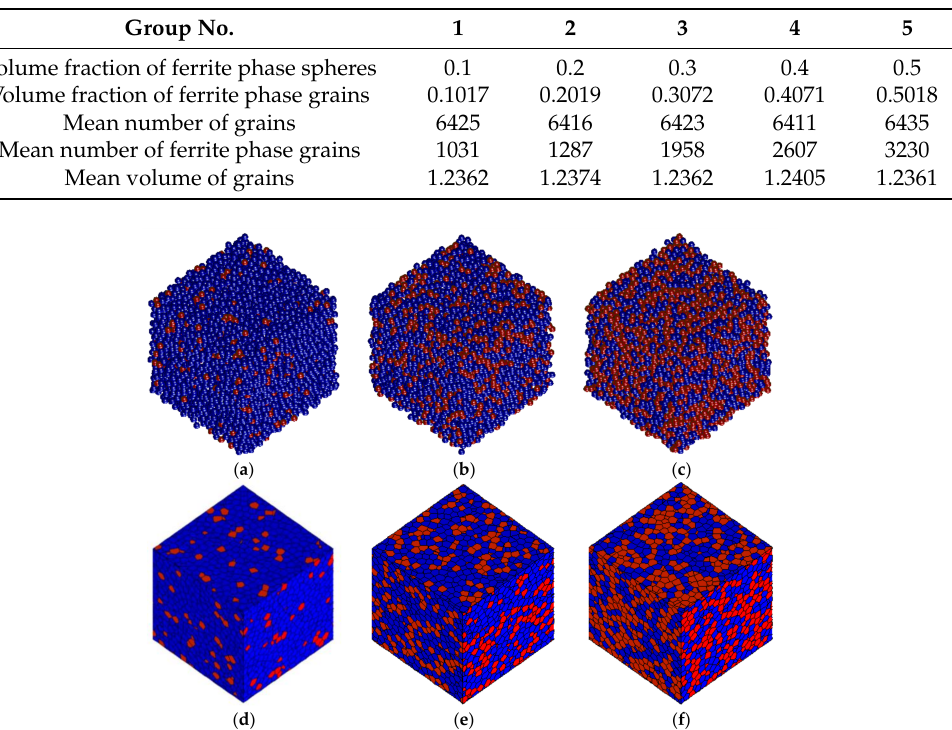
Table 1. Characteristics of each group model.